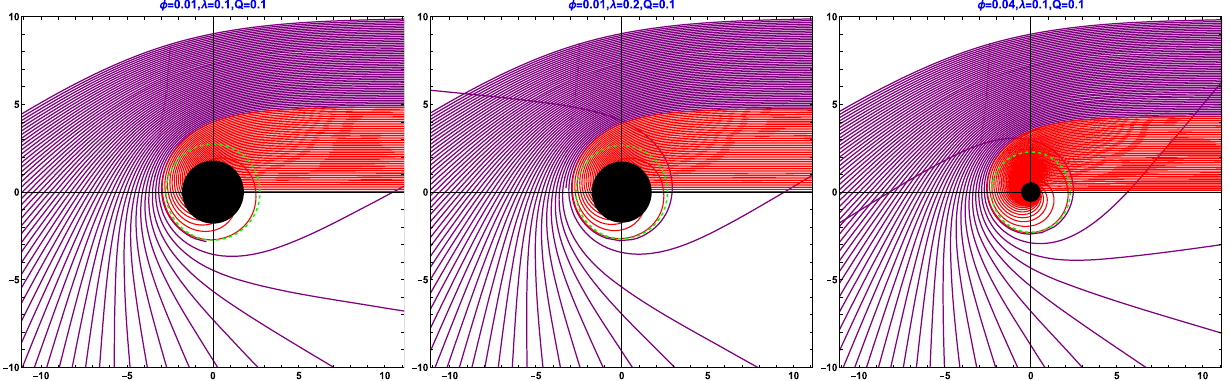
Fig. 2 The light rays for different specific values of model parameters in polar coordinates ( r ,ϕ) with M = 1. The purple and red curves classified the b > b ph and b < b ph regions, respectively. The dashed green line denotes the radius of photon sphere and solid black disk represents the BH face